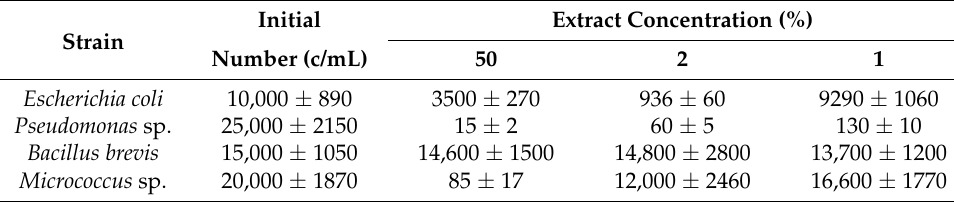
Table 5. The number of bacterial cells in solution (c/mL) when an aqueous extract is used. Initial Strain